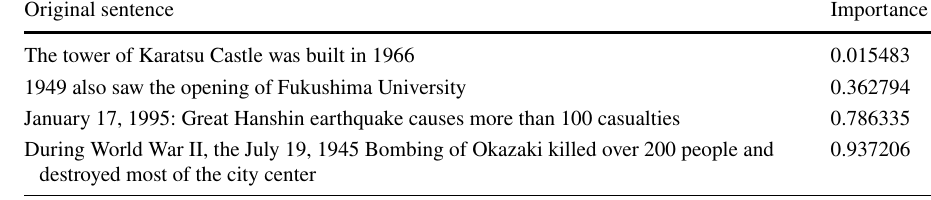
Table 1 A sample of four historical events with their estimated importance scores from the histories of Japanese D cities (dataset 1 , see Sect.